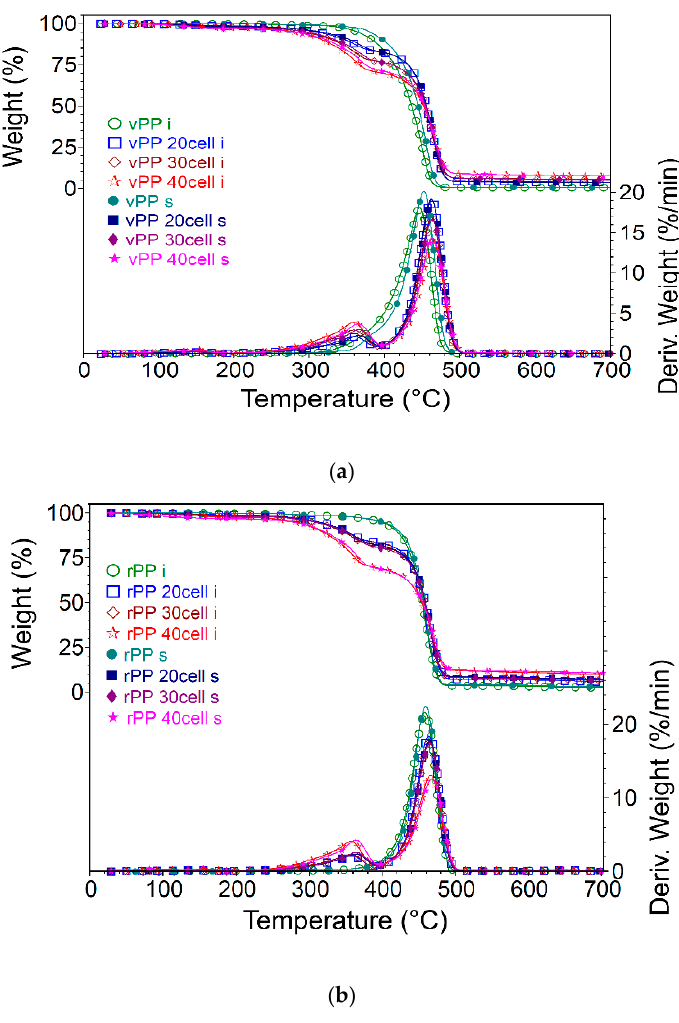
Figure 6. TGA curves of PP-cellulose composites. ( a ) vPP-cellulose composites and ( b ) rPP-cellulose composites.